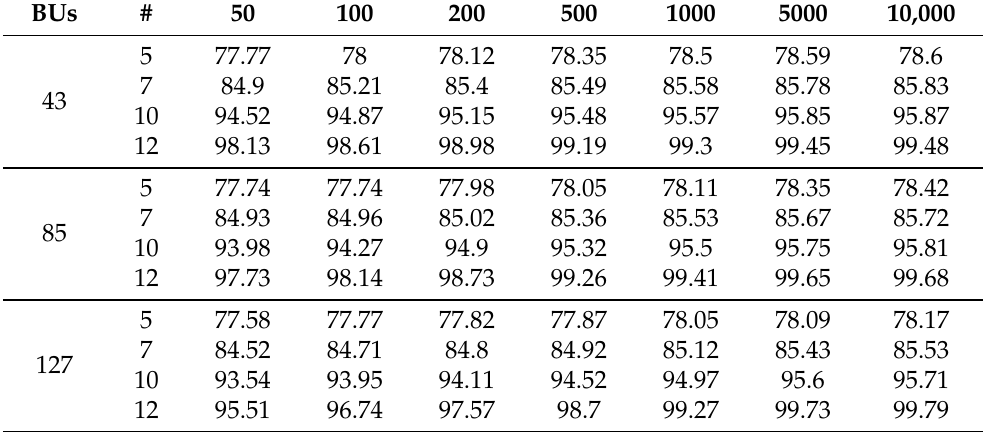
Table 2. Average of late deliveries on the worst day by number of solutions generated during the first phase of the algorithm, Columns ‘50’, ‘100’, ‘200’, ‘500’, ‘1000’, ‘5000’, and ‘10,000’ and instance parameters (number of basic units, column ‘BU’, and number of districts generated, column ‘#’) for instances with medium